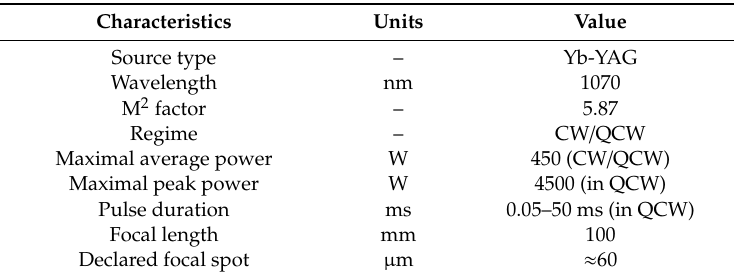
Table 2. Main laser characteristics. Abbreviations: YAG: yttrium aluminum garnet; CW: continuous wave; QCW: quasi continuous wave.